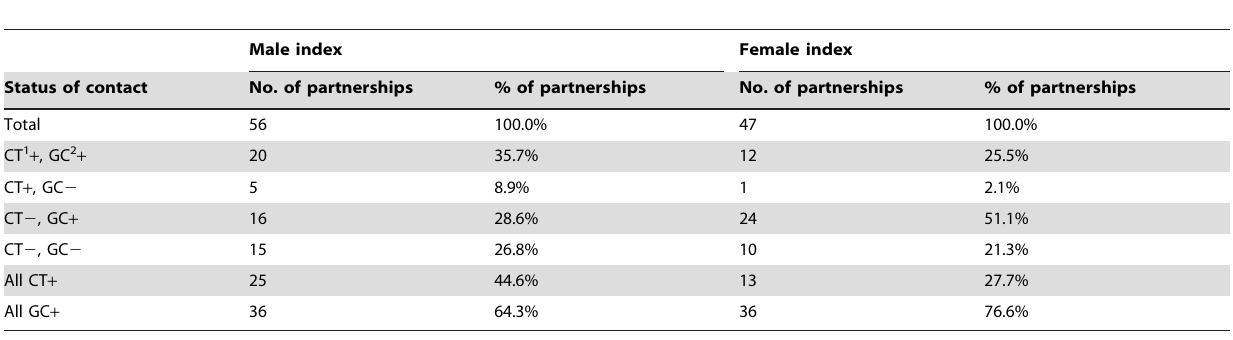
Table 2. Data from Lycke et al. [45] on case contact pairs for gonorrhoea and